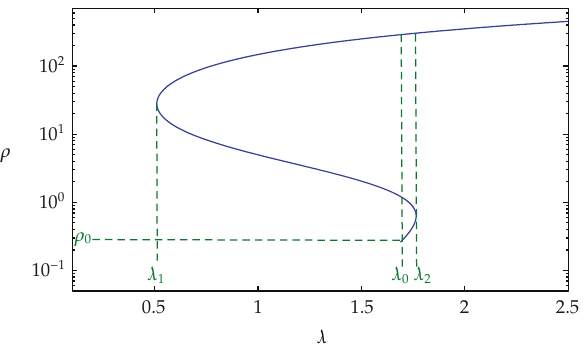
Figure 12: Graph of λ versus ρ for β (cid:3)